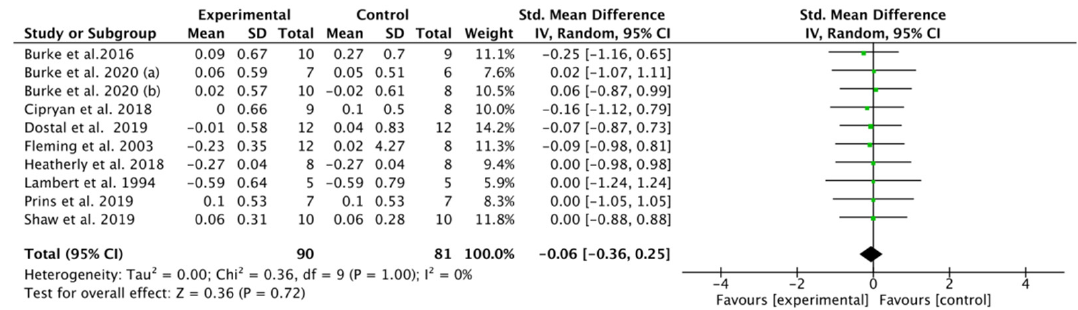
Figure 3. Effect of the ketogenic low-carbohydrate, high-fat (K-LCHF) diet on VO 2 max during graded exercise test (GXT); CI: confidence interval; SMD: standardized mean difference.